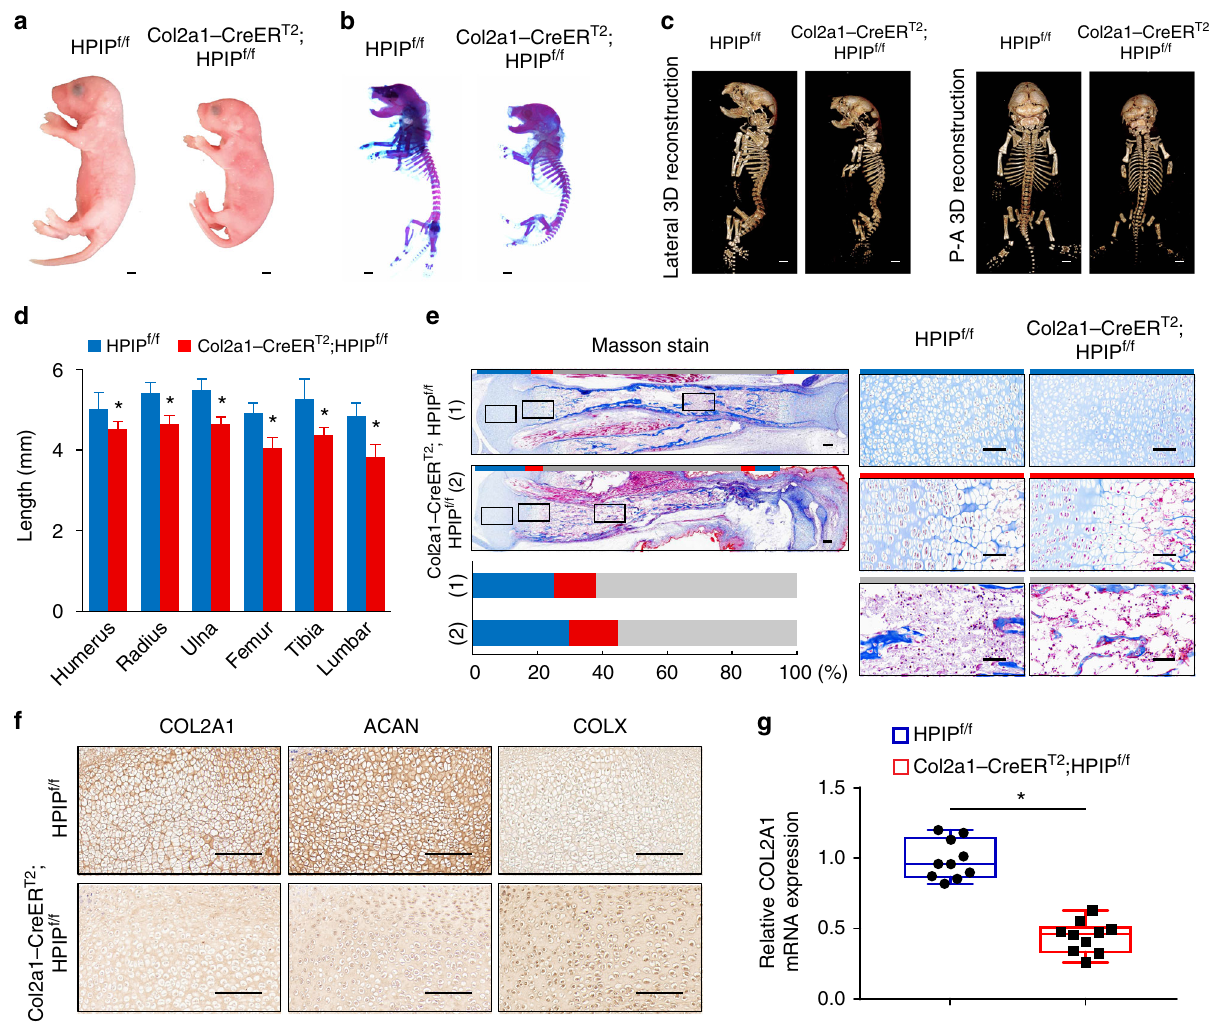
Fig. 2 Skeletal and cartilage abnormalities in Col2a1-CreER T2 ;HPIP f/f mice. a Col2a1-CreER T2 ;HPIP f/f mice and HPIP f/f littermate embryos (P1). Scale bar, 1 mm. b Double staining with alizarin red and alcian blue of the whole skeleton. Scale bar, 1 mm. c Lateral and posterior – anterior (P – A) views of μ CT three- dimensional reconstruction analysis. Scale bar, 1 mm. d The length of long bones and vertebra ( fi rst to fi fth lumbar spines) of HPIP f/f ( n = 10) and Col2a1- CreER T2 ;HPIP f/f ( n = 10) littermate embryos (P1). e Masson trichrome staining of whole tibias. The boxed areas represent the regions of right magni fi ed images with a matched color rim. Scale bar, 100 μ m. The percentage of the length of the proliferative zone (blue), hypertrophic zone (red), and bone area (gray) over the total tibia length of HPIP f/f ( n = 10) and Col2a1-CreER T2 ;HPIP f/f ( n = 10) littermate embryos (P1). f , g Representative immunohistochemistry assay ( f ) with the indicated antibodies of the proximal tibias of HPIP f/f and Col2a1-CreER T2 ;HPIP f/f littermate embryos (P1) and boxplots showing qRT-PCR ( g ) of the proximal tibias of HPIP f/f ( n = 10) and Col2a1-CreER T2 ;HPIP f/f ( n = 10) littermate embryos (P1). Scale bar, 100 μ m. Center value represents the median of the HPIP scores. The bounds of box represent the upper quartile and the lower quartile. The whiskers represent the maximum and minimum score. Error bar represents the standard deviation (s.d.) and P- value was generated by using one-way ANOVA with Tukey ’ s post hoc test. * P < 0.05; ** P <